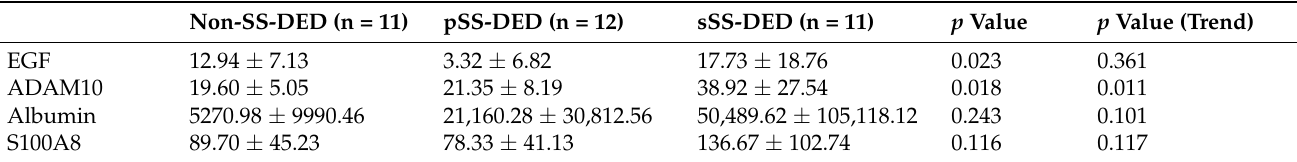
Table 4. The verification of various proteins with ELISA in tears of